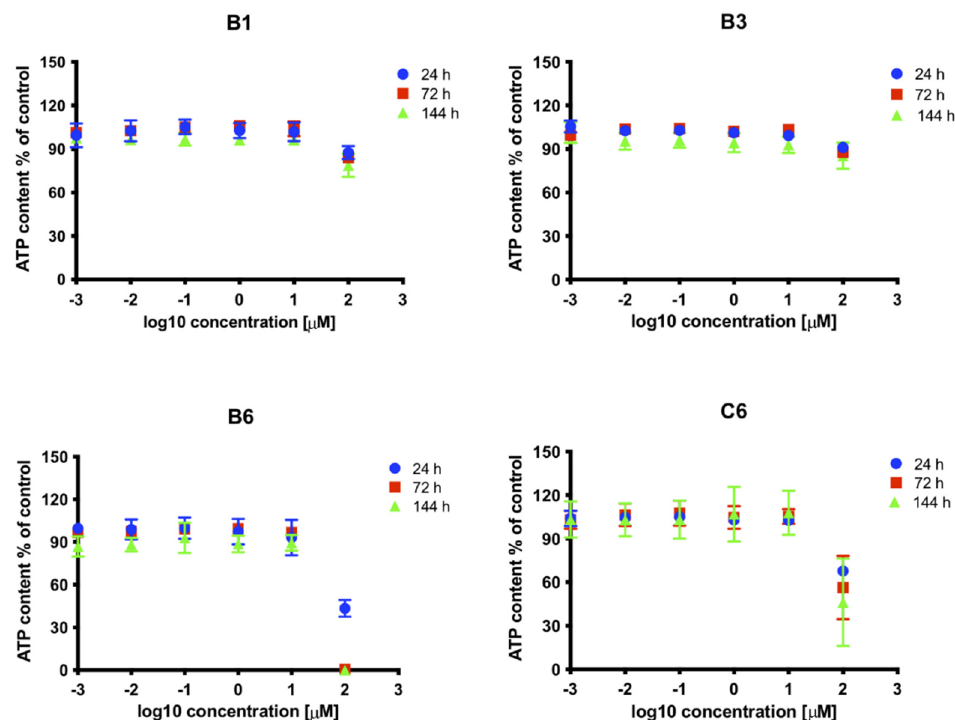
Figure 4. Effect on cell viability and proliferation of SMs inhibiting HCMV replication. MRC5 cells were treated with increasing concentrations of indicated compounds or with solvent only, as described in the Materials and Methods section. At the indicated time, post treatments cells were processed for intracellular ATP quantification. Data shown are the mean + standard error of the mean relative to 3 independent experiments.